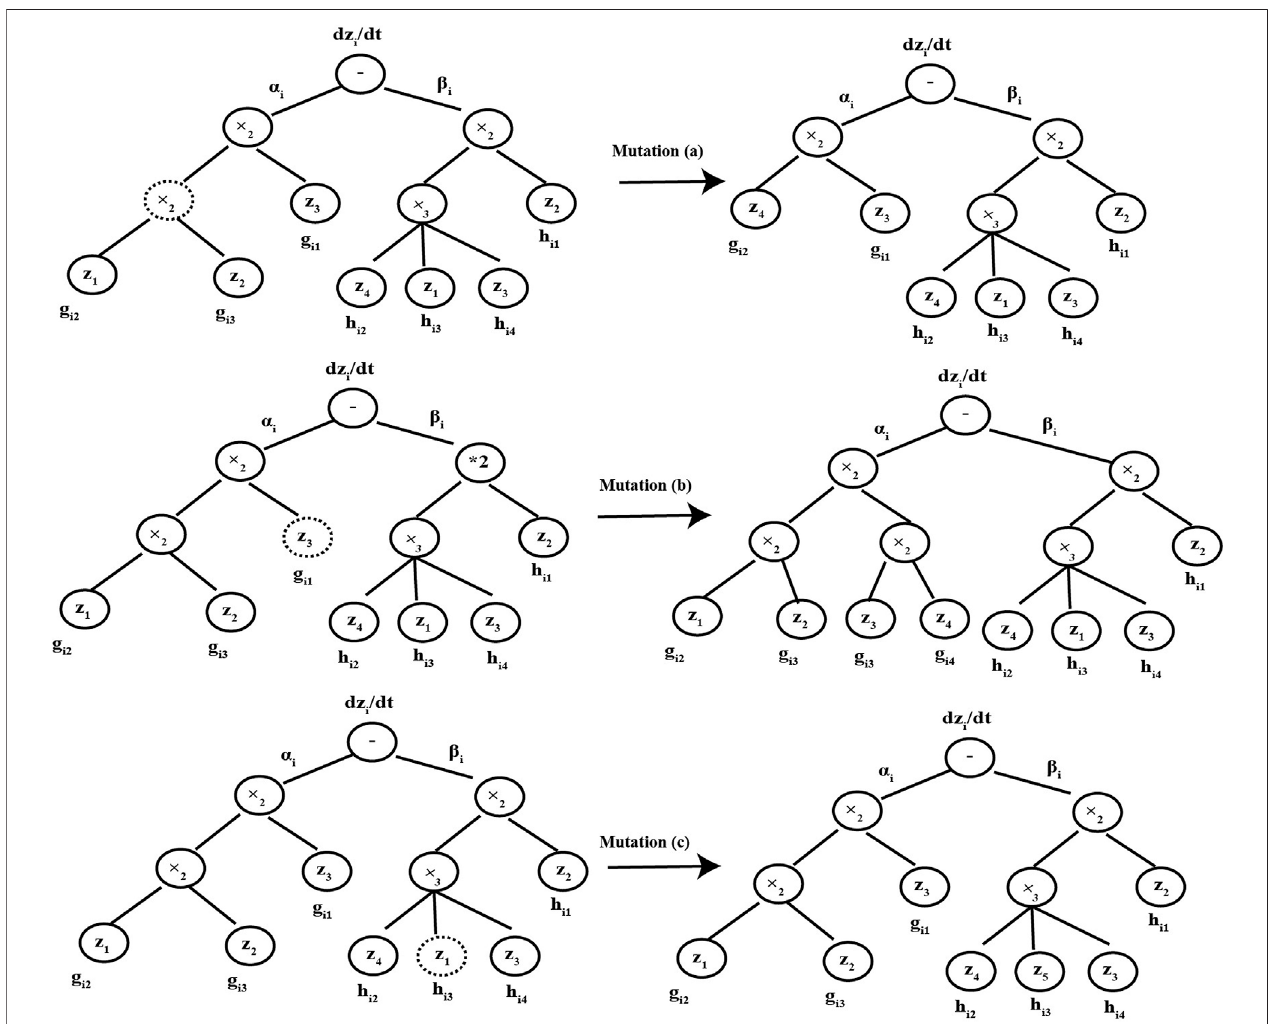
FIGURE 3 | Mutation